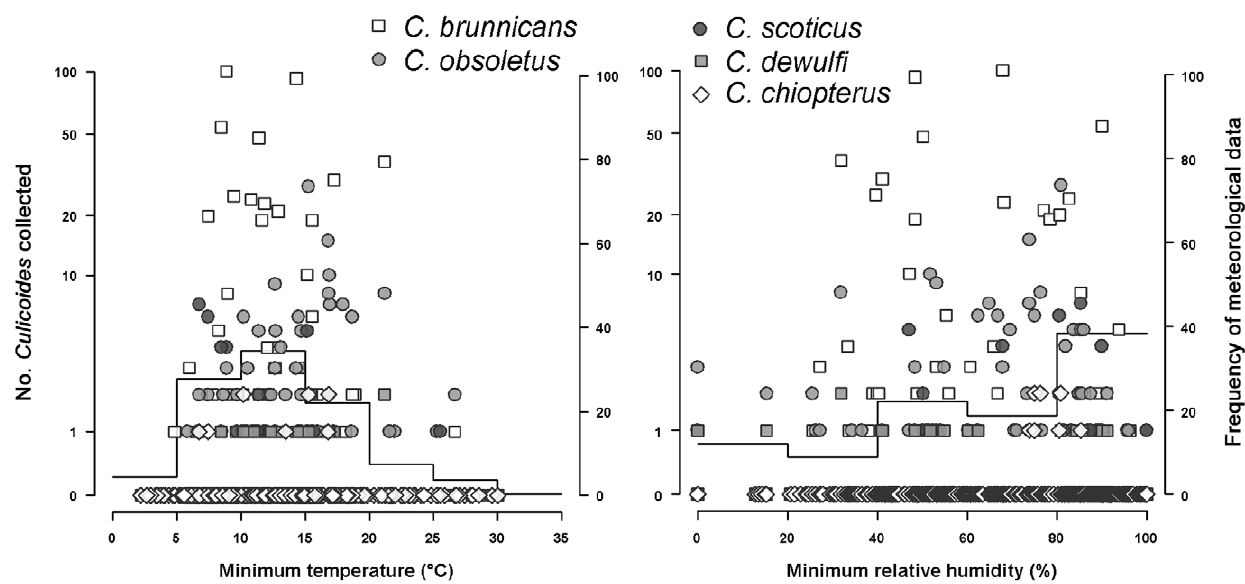
Figure 5. Sketch map of the study site at Nouzilly (western France) with the location of the sheep-baited traps (drop trap and suction trap) in the three sites (field, large-open-stable, closed stable) and of the UV-light/suction trap.